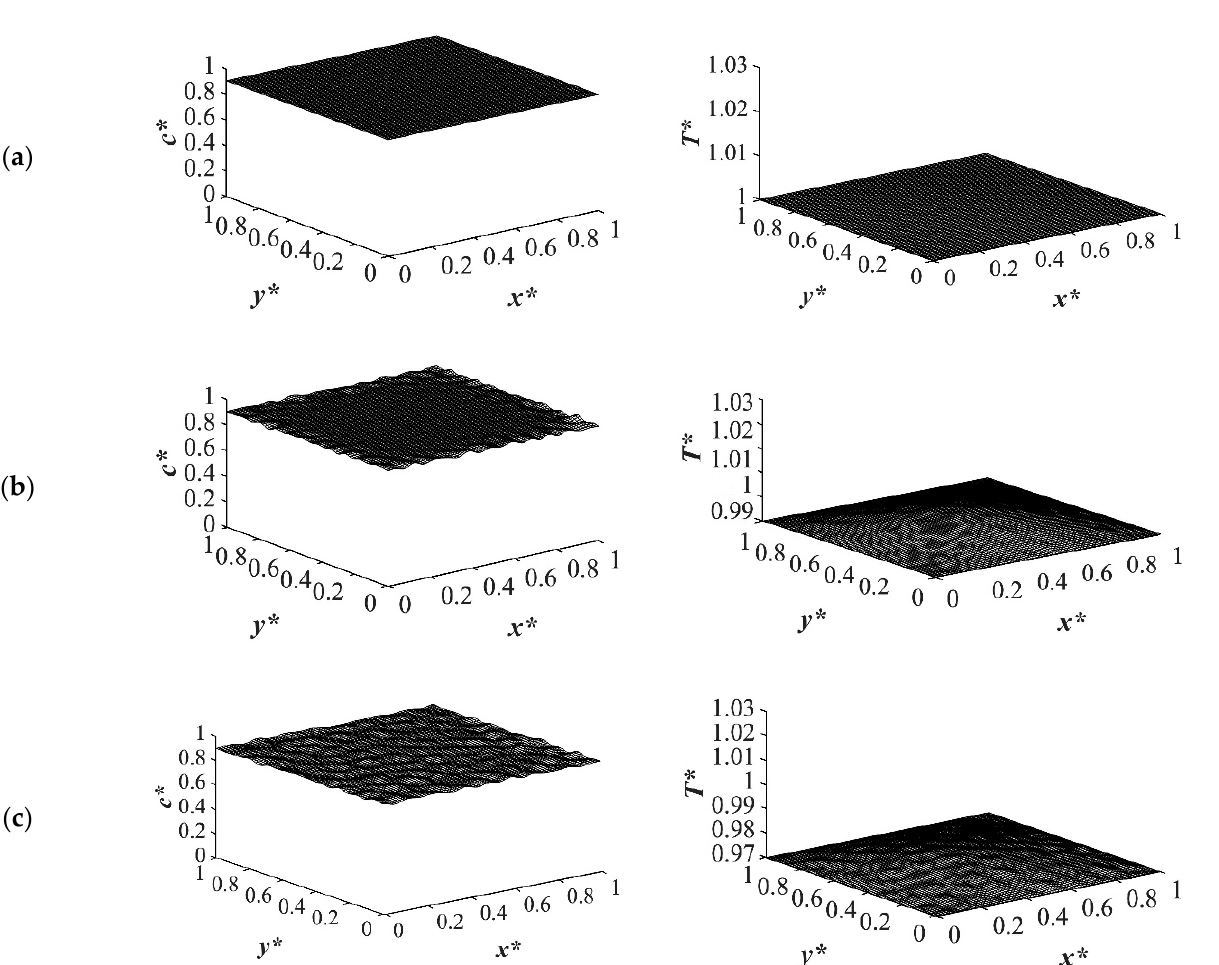
Figure 7. Spatial concentration ( left column) and temperature ( right column) profiles for the off- critical quench to c * = 0.909 at t * = 2.03 × 10 − 5 for three different quench depths of ( a ) T * q1 = 1.0, ( b ) T * q2 = 0.99 ( c ) T * q3 = 0.97.